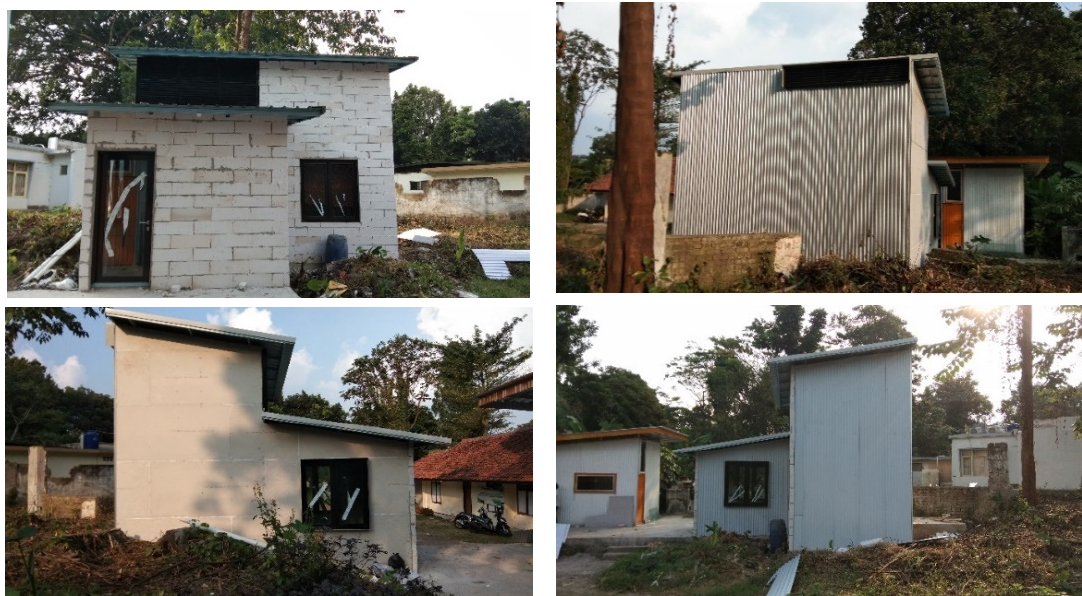
Figure 5. From the upper left clockwise, cladding material for each orientation: (1) west facade: Hebel ® ; (2) east facade: Spandek ® ; (3) south facade: uPVC Alderon RS ® ; and (4) north facade: GRC KalsiClad ® . Table 3. The construction speed of cladding wall materials.